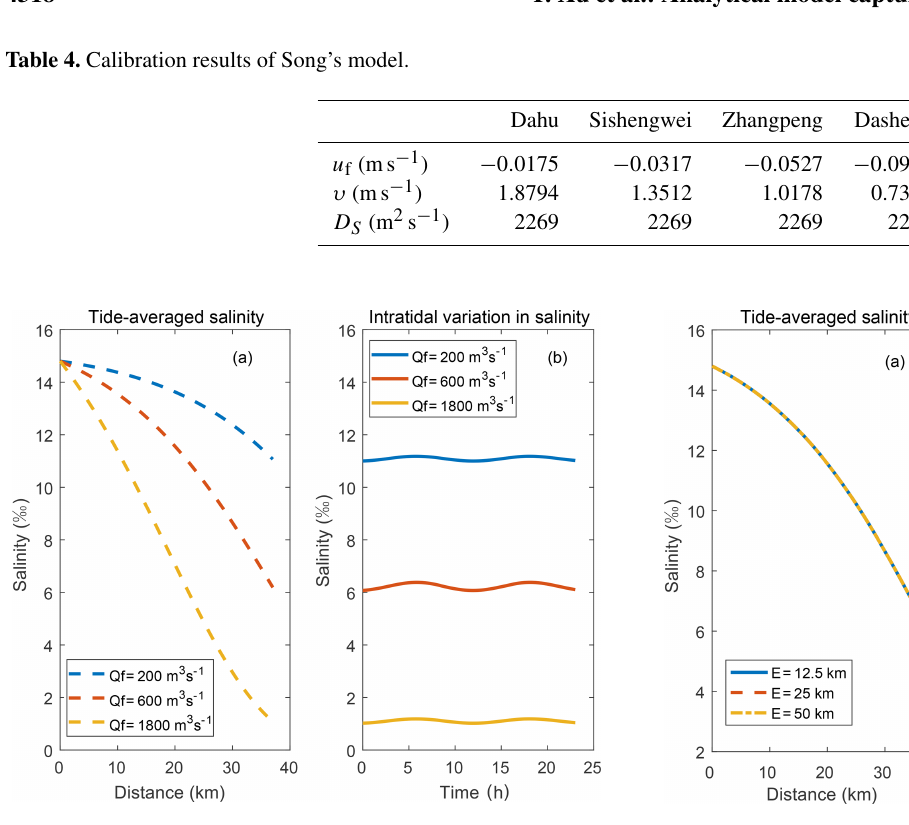
Figure 9. (a) Longitudinal salt intrusion curve at tidal average, con- sidering different river discharge values; (b) intratidal variation in salinity at Huangpuyou station on 31 January 2005, considering dif- ferent river discharge values.